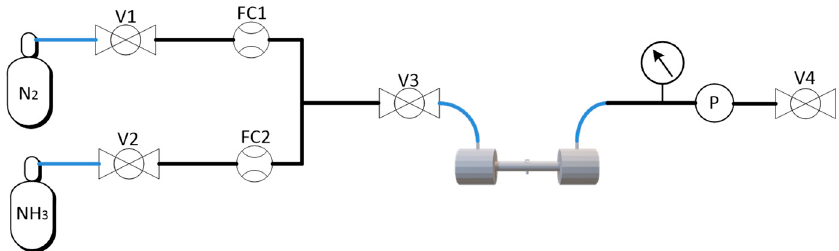
Figure 4. Piping, instrumentation, and safety flow diagram. V, valves; FC, Flow control; P, Pressure